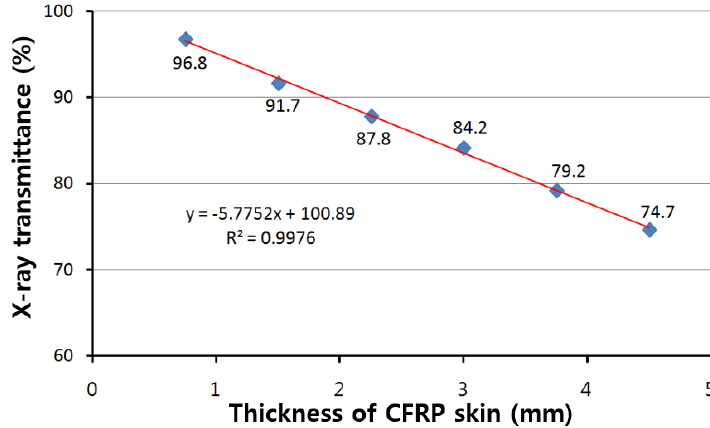
Figure 2. X-ray Transmission ratio of facing materials.